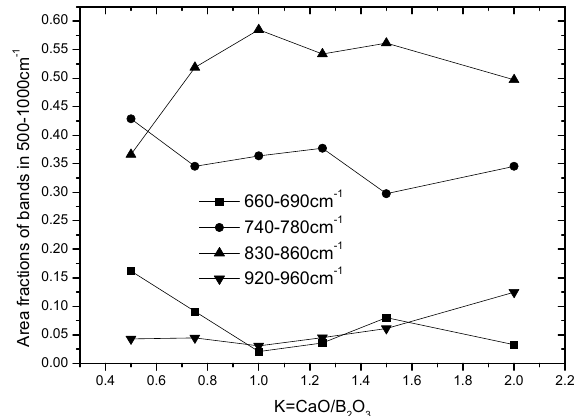
Figure 7. Area fractions of bands in 500–1000 cm (cid:3) 1 as functions of x (TiO 2 / .